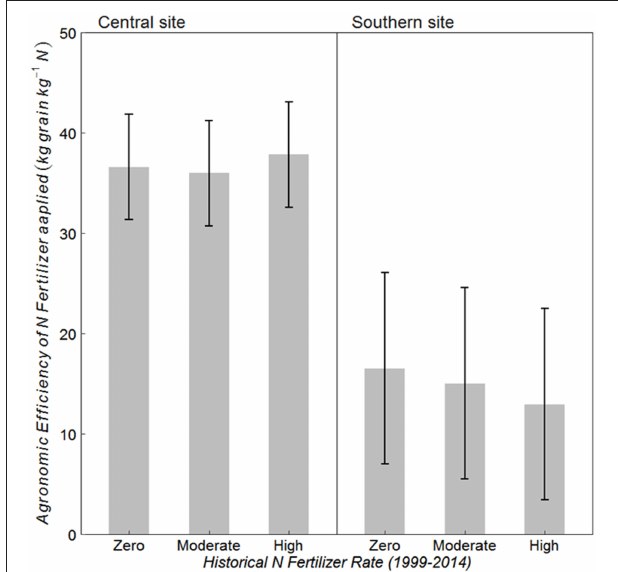
FIGURE 3 | Mean agronomic efficiency (AE) of applied N fertilizer for continuous maize system with three historical N rates (1999–2014) of zero, moderate (202 and 224kg N ha − 1 yr − 1 at central and southern sites, respectively) and the highest rate (269kg N ha − 1 yr − 1 ) at the central, and southern Iowa sites. Vertical bars represent 95% confidence